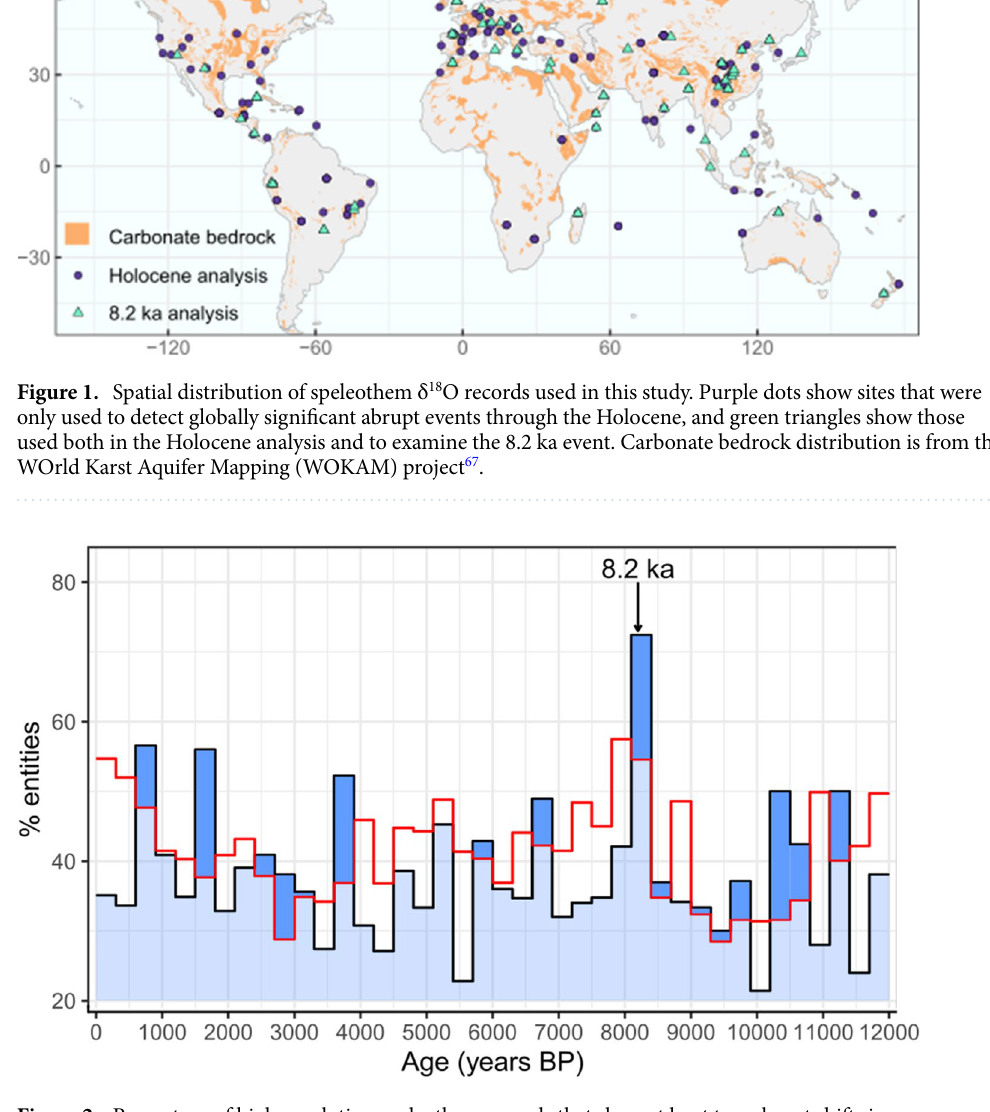
Figure 2. Percentage of high-resolution speleothem records that show at least two abrupt shifts in oxygen isotope values, for a given 300-year bin, across the Holocene epoch. The 8.2 ka event is annotated. The red line represents the percentage of randomly generated records (with red noise) that show > = 2 breakpoints in a 300- year bin. The bins that are higher than the randomly generated noise (and therefore significant) are shown in dark